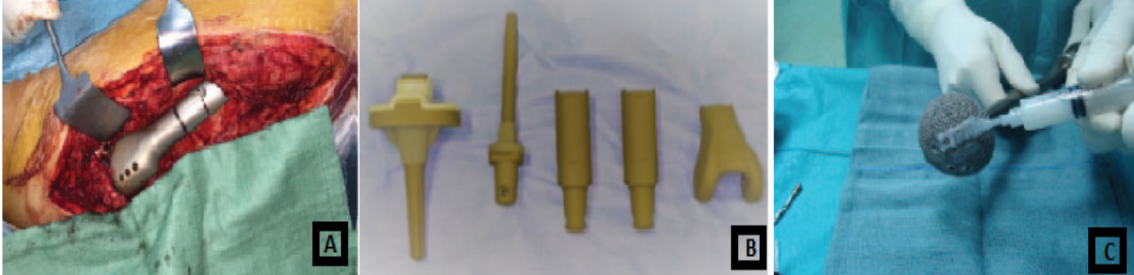
Figure 11. Examples of antibacterial coatings: ( A ) silver-coated; ( B ) iodine-coated; ( C ) vancomycin-loaded Defensive Antibacterial Coating (DAC) hydrogel, applied at the time of surgery on an acetabular titanium component [54]. A 2019 Creative Commons Attribution (CC BY) license.